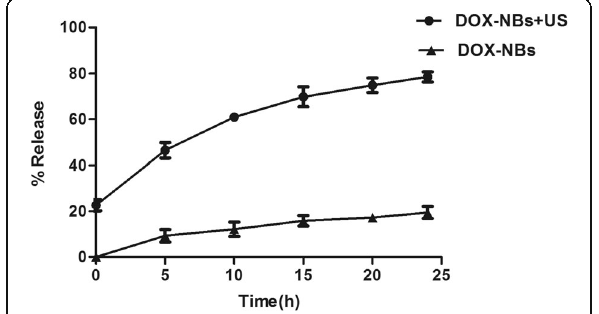
Fig. 4 Doxorubicin release from DOX-NBs with or without ultrasonic irradiation (2 kHz, 1.0 W/cm 2